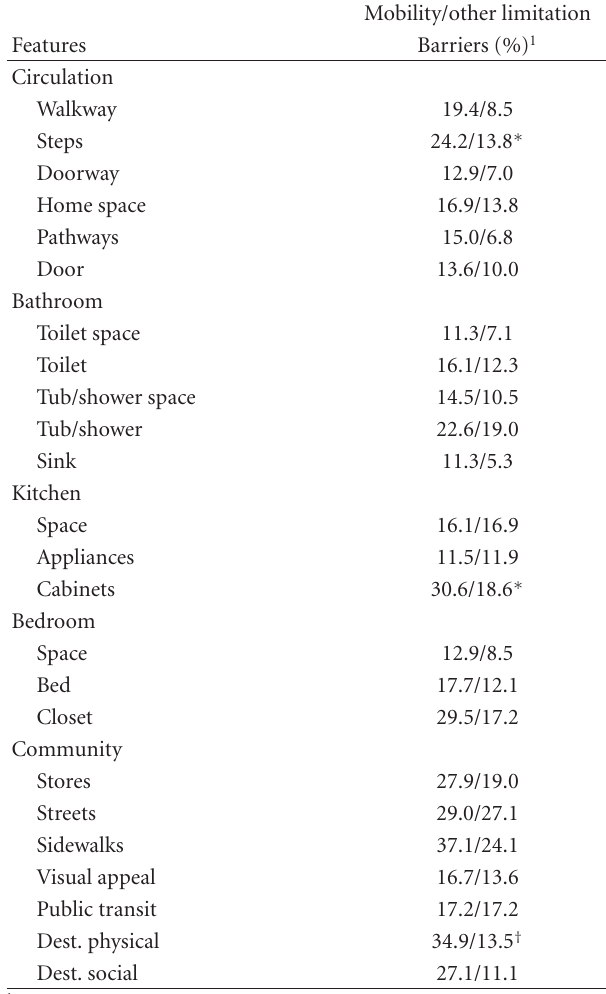
Table 3: Perceived home and community barriers by percentage of